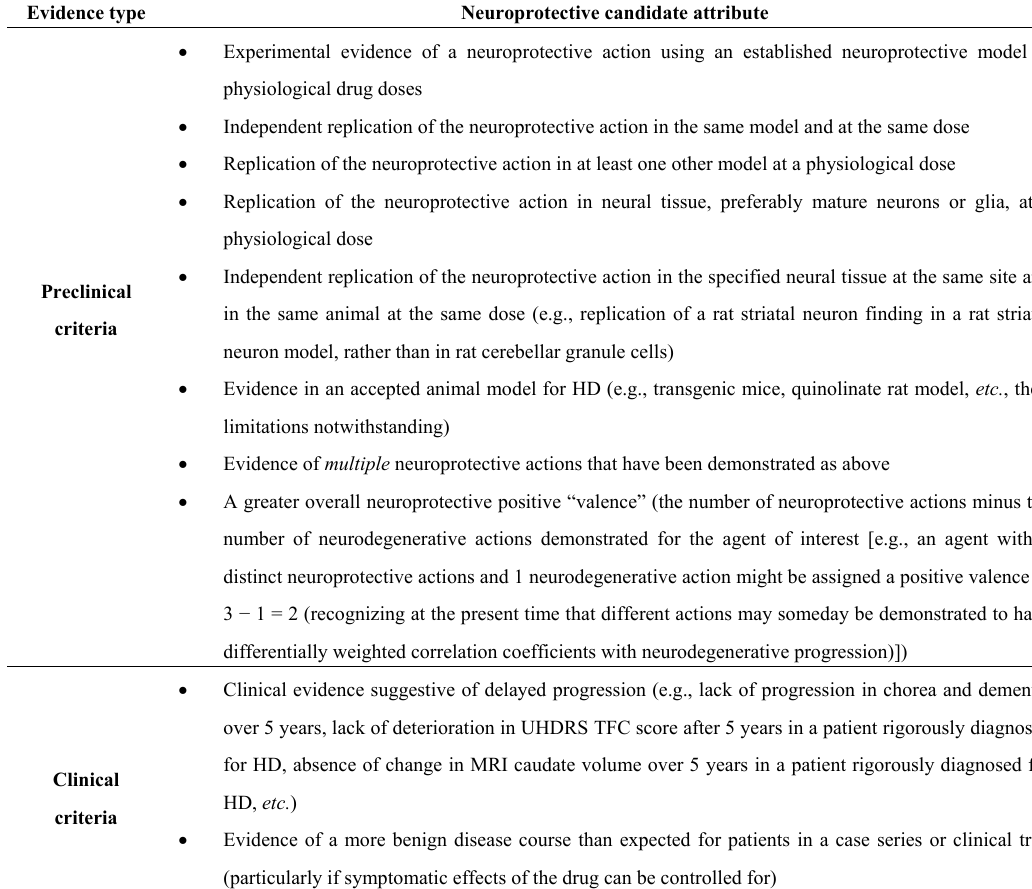
Table 4. Criteria for determining candidate agents for clinical trials in